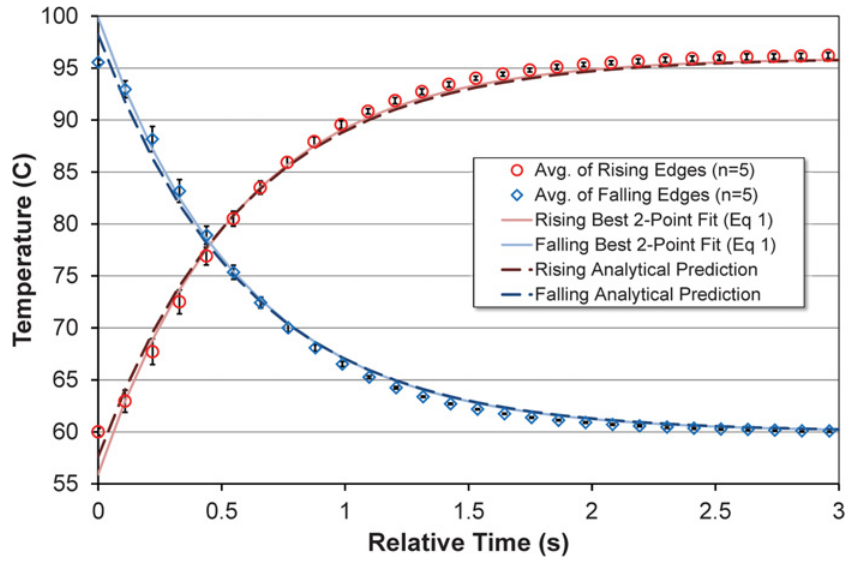
Fig 8. Comparison of average thermocouple-measured rise and fall times derived from the five cycles depicted in Fig. 7 with a parametrically fitted bounded exponential curve of the form of Equation 1, and response curves predicted analytically a priori from Equations 1, 2, and 4.